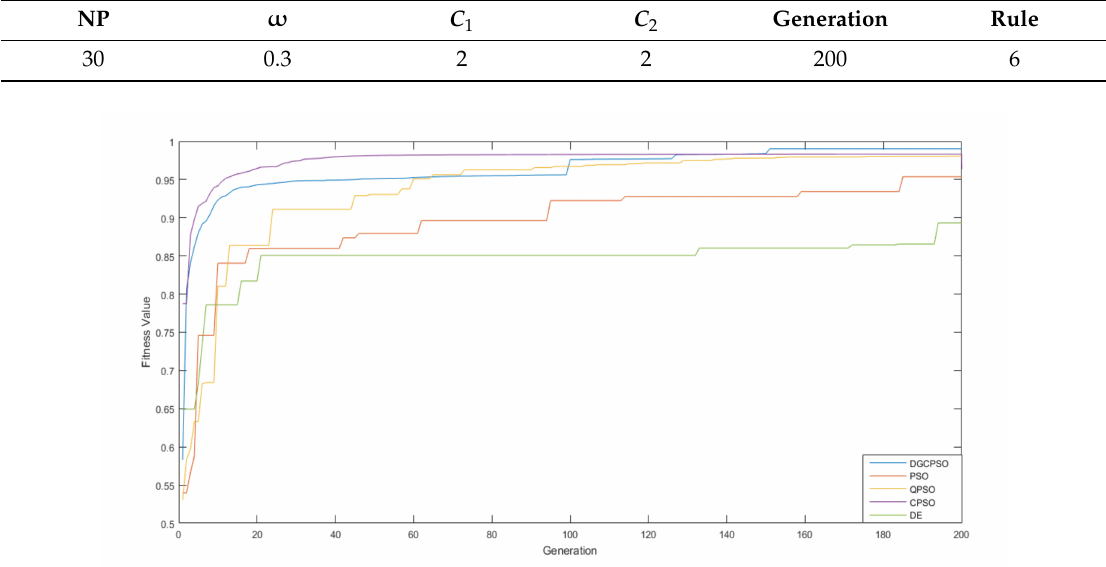
Table 3. Parameter setting of chaotic time-series.